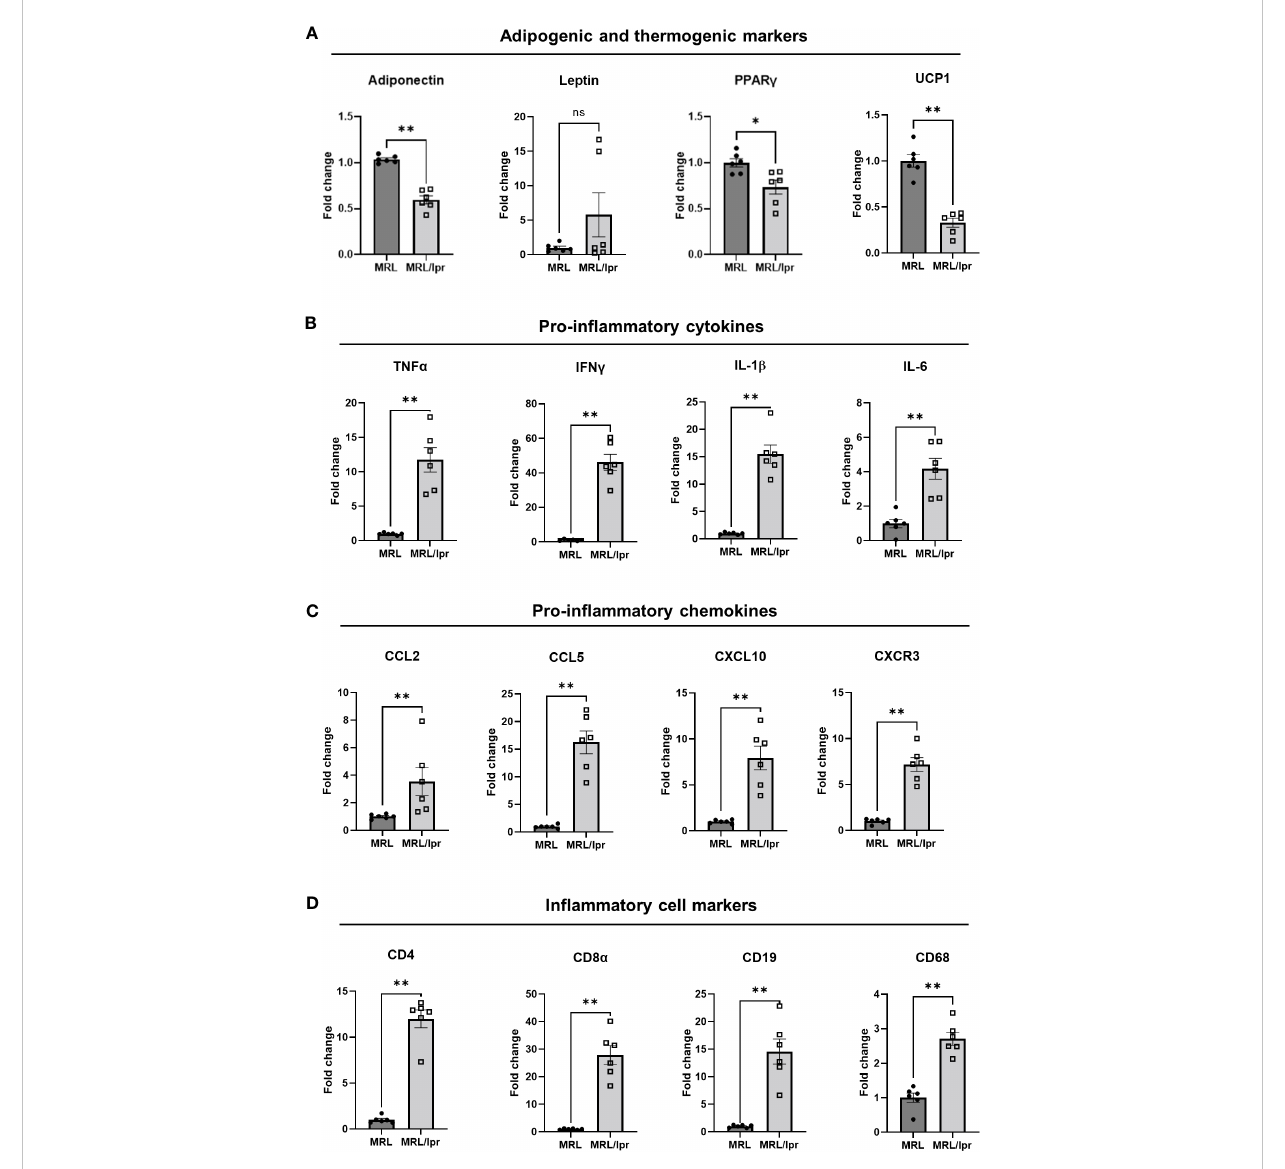
FIGURE 6 PVAT from MRL/lpr mice exhibited decreased adipogenic and thermogenic marker genes (A) , and increased proin fl ammatory genes including cytokines (B) , chemokines (C) , and in fl ammatory marker (D) genes. n=6. *p<0.05, **p < 0.01, vs MRL (control). ns, not signi fi